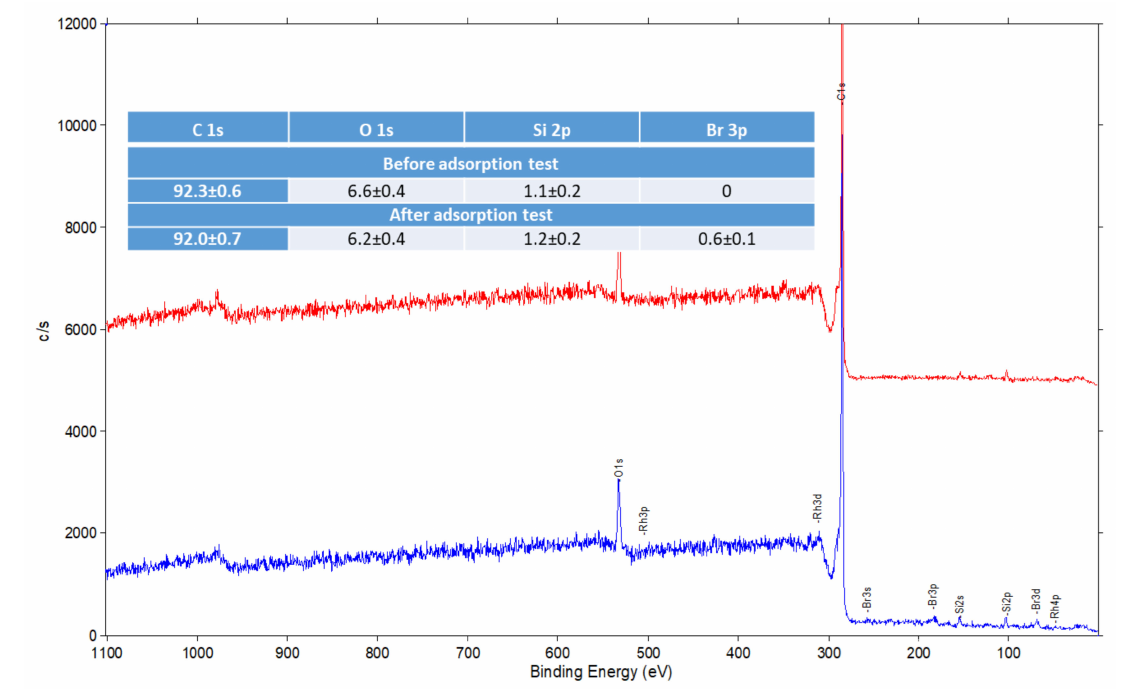
Figure 15. Survey XP spectra for the samples of activated carbon before and after adsorption tests.